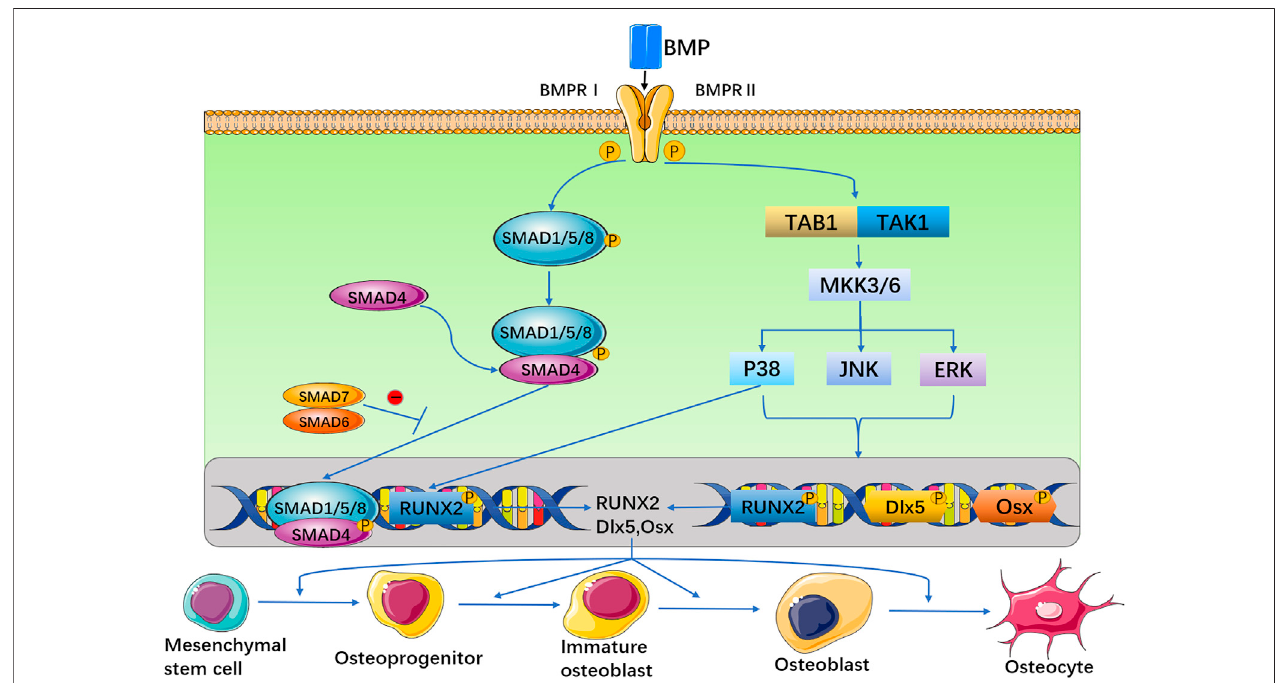
FIGURE 1 | The BMP signal is transduced through BMPRI and BMPRII receptors. These two receptors are combined into a functional complex, to initiate further signaling pathways. On the one hand, activated BMP type I receptor phosphorylates Smad-dependent signaling pathways. On the other hand, BMP receptors activate non-Smad-dependent signaling pathways, that is, activate p38 MAPK, JNK, and ERK signaling pathways. Then, BMP can stimulate the expression of threeosteogenic main transcription factors Runx2, D1x5 and Osx.